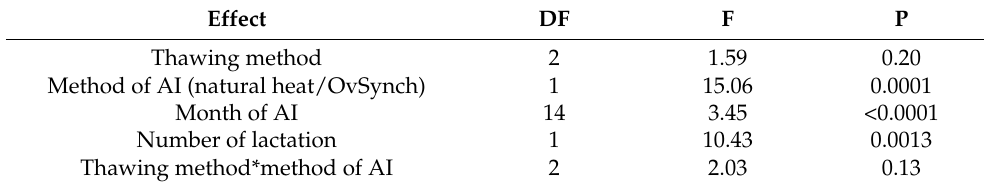
Table 6. Results of the second step of the GLMM with the inclusion of the random effect.